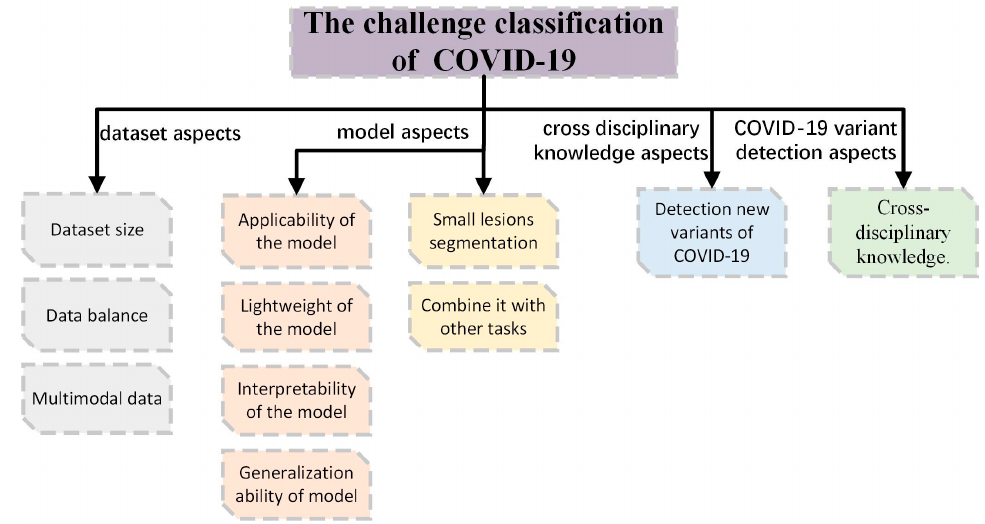
Figure 6. Challenge of diagnostic methods for COVID-19.